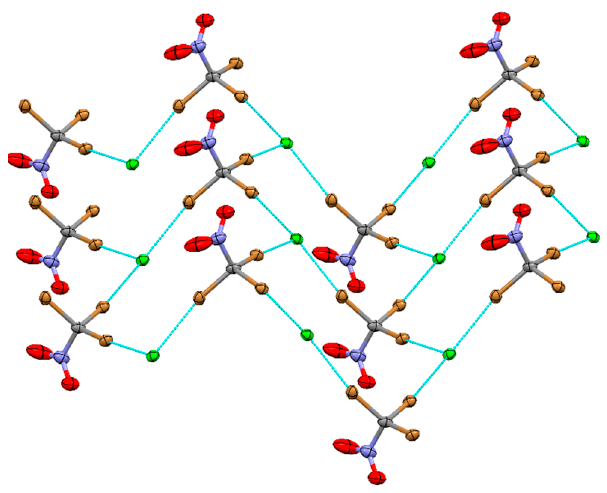
Figure 5. XB networks in (DABCO-CH 2 Cl)Cl ·CBr 3 NO 2 co-crystals 5.